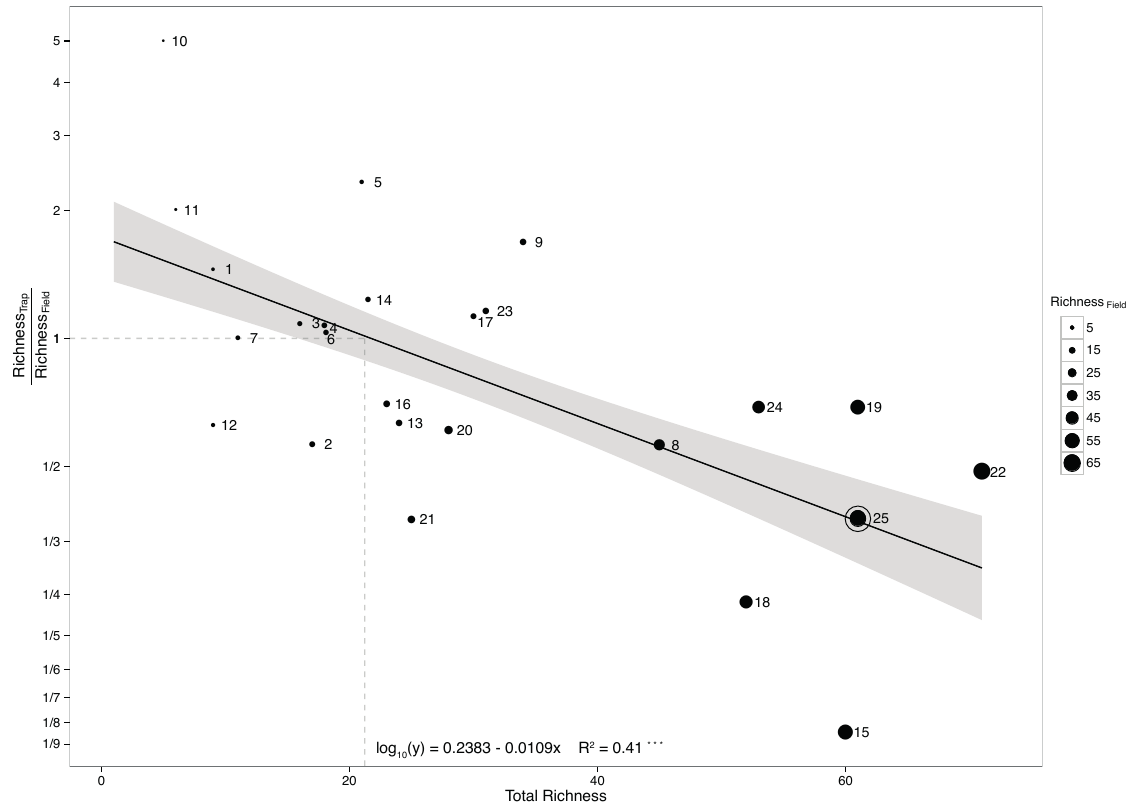
Figure 5 – Trap relative performance as related to AMF richness detected by direct analysis of fi eld samples based on publications 1 to 24 (see Table I) and results of the present study (25). The estimated model (F solid line indicates the fi tted values and the grey area indicates the standard